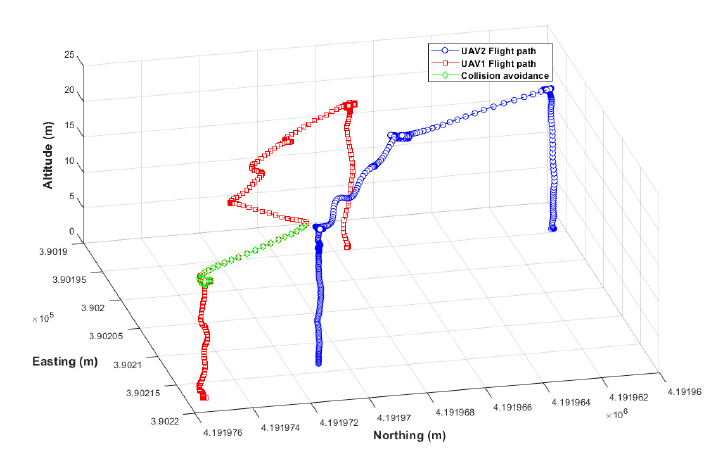
Figure 21. Actual flight trajectory with the collision avoidance algorithm.